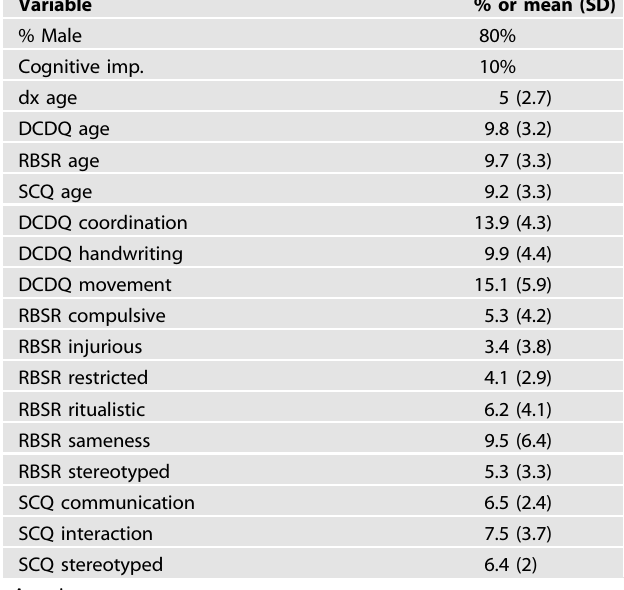
Table 1. Demographic and autism subscale summary of SPARK individuals in this study ( N =